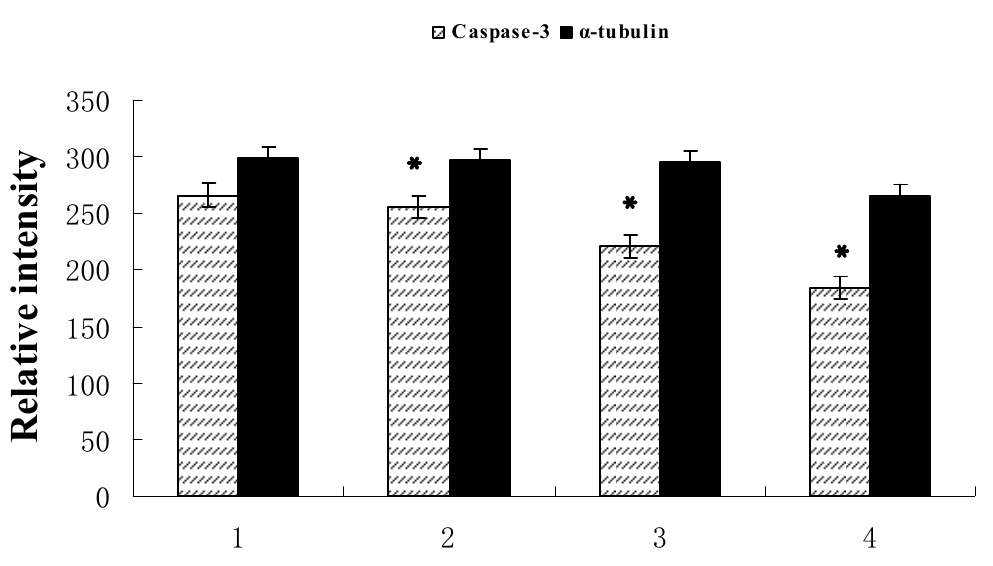
Figure 6. Protein expression